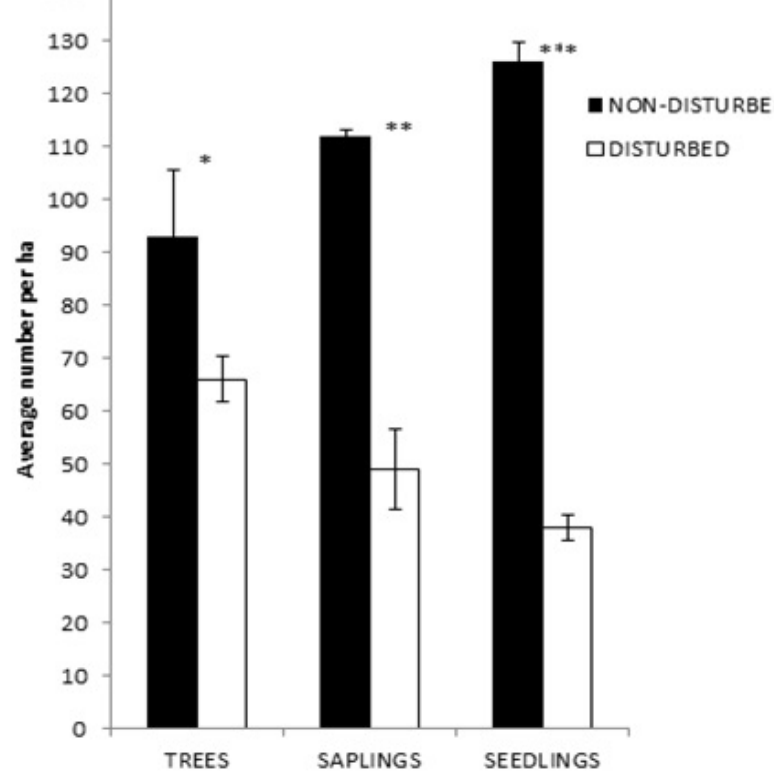
Figure 4. Average ± SE number of stems of mature trees, saplings, and seedlings per ha across all tree species plotted along the disturbed and non-disturbed sites. Asterisks above bars signpost significant differences within the growth stages across the disturbed and non-disturbed sites according to Tukey’s Post-Hoc tests (* = p < 0.05; ** = p < 0.01; *** = p < 0.001).